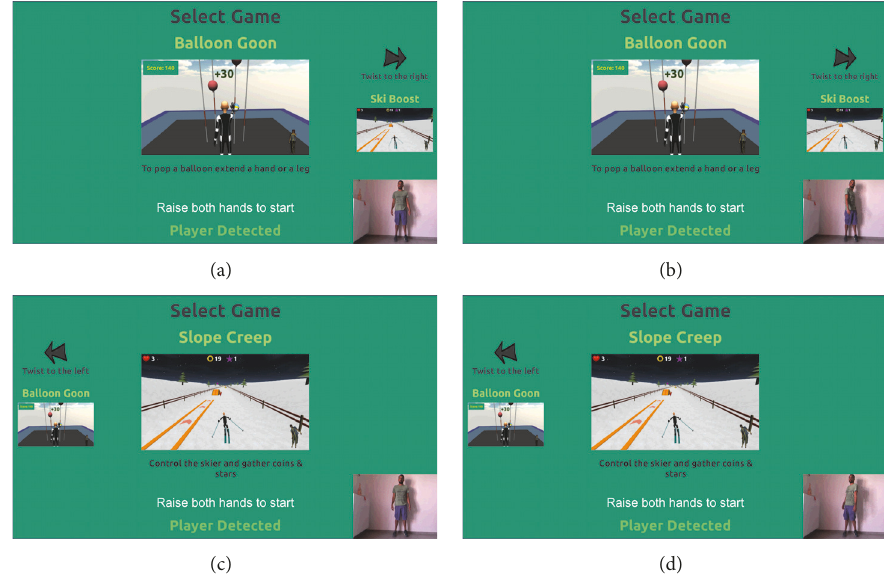
Figure 1: A sequence of screen snapshots displaying the “Twist Torso to Navigate” gesture in action; (a) the player faces the TV monitor which shows the current (Balloon Goon) exergame. He is instructed to either raise both hands to select and start the shown game or twist to the right to select the next game (Slope Creep); (b) by twisting his torso to the right, the player opts to navigate to the next (Slope Creep) game; (c) the right torso twist gesture has now been recognized; as a result, the Slope Creep game is shown and can be selected; (d) the player, however, opts to twist to the left in order to return to the previous (Balloon Goon) game. When the left torso twist gesture is recognized, the screen on the monitor will again be that shown in (a).